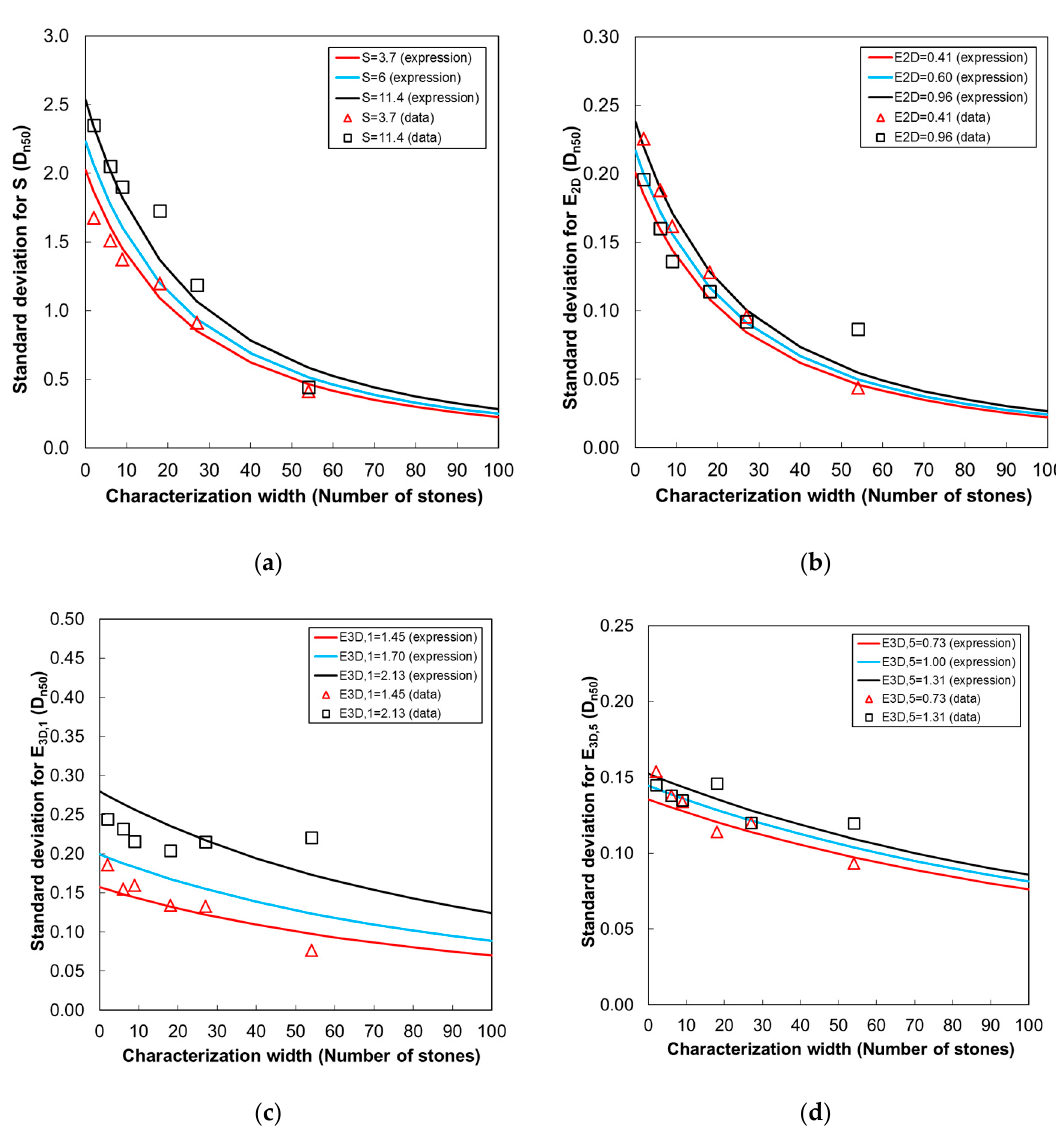
Figure 10. Fit (Equations 3a–d) to the obtained standard deviations from the measurements (standard deviations versus the number of stones over the width of the test section). ( a ) S parameter; ( b ) E 2D parameter; ( c ) E 3D,1 parameter; ( d ) E 3D,5 parameter.